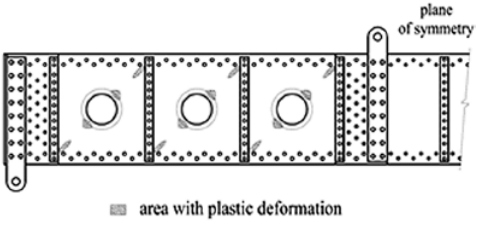
Fig. 13. Most critical areas of the web for diagonal